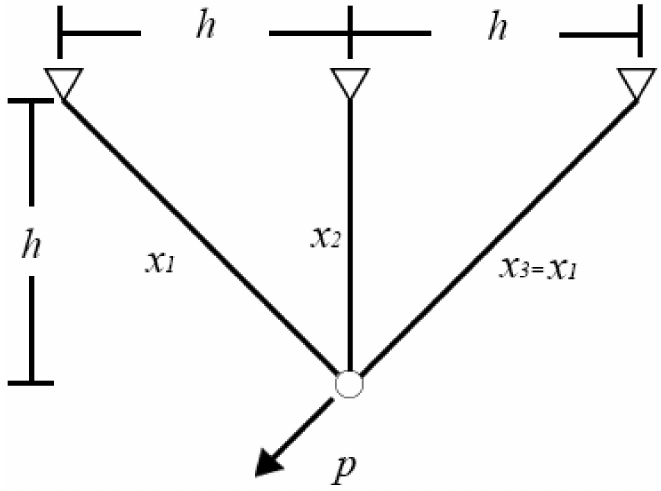
Figure 7. Three-bar truss